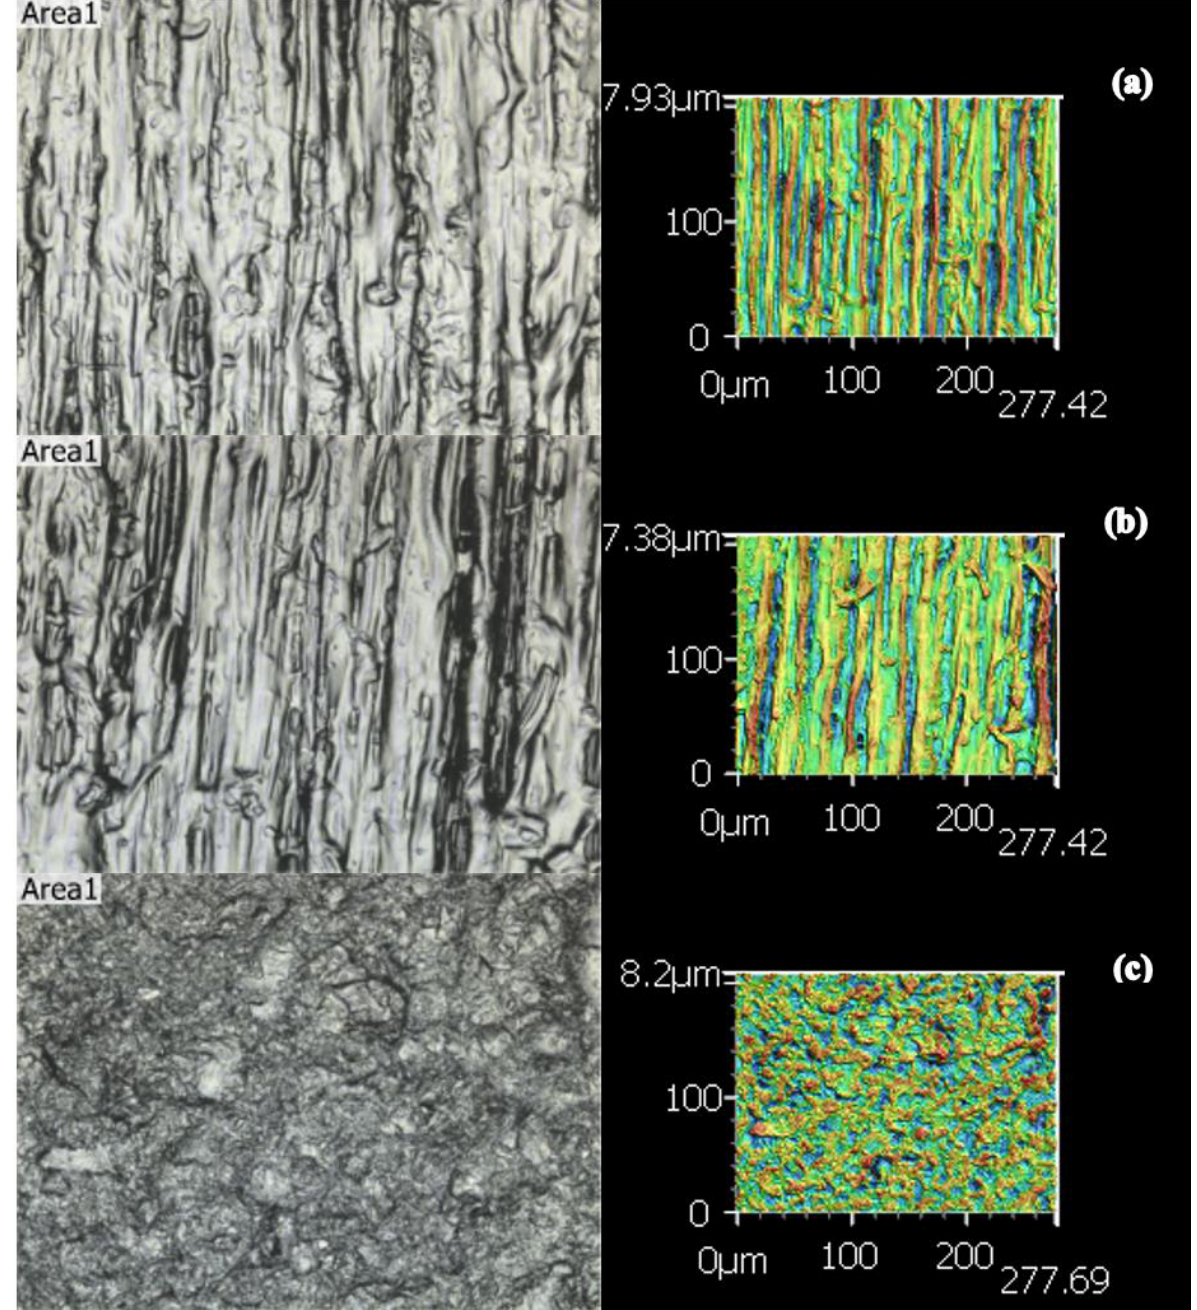
Figure 1. Surface roughness analysis by 3D laser scanning confocal microscope at 50 × with optical and laser lenses in both grey shades and height-indicated colored images for: ( a ) Control, ( b ) Extra- cured, and ( c ) Sandblasted samples.